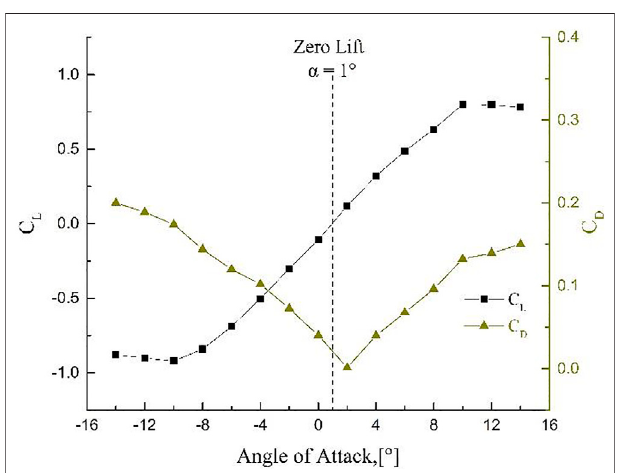
FIGURE 3 | Lift-drag performance of hydrofoil with different angles of attack.